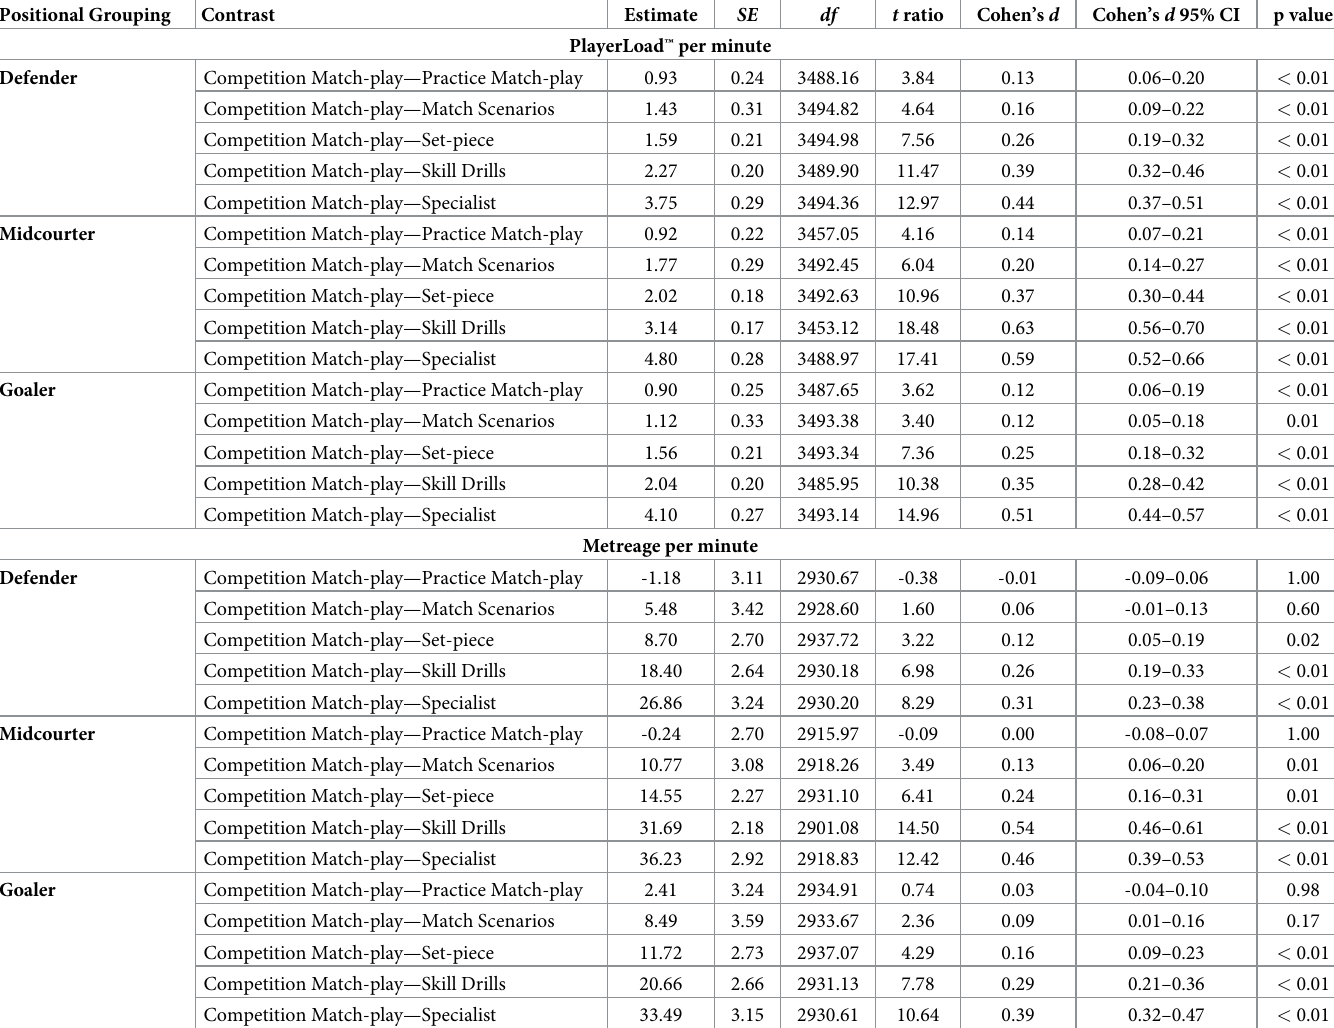
Table 1. Model contrasts comparing each training activity type to competition Match-play by positional group. Positional